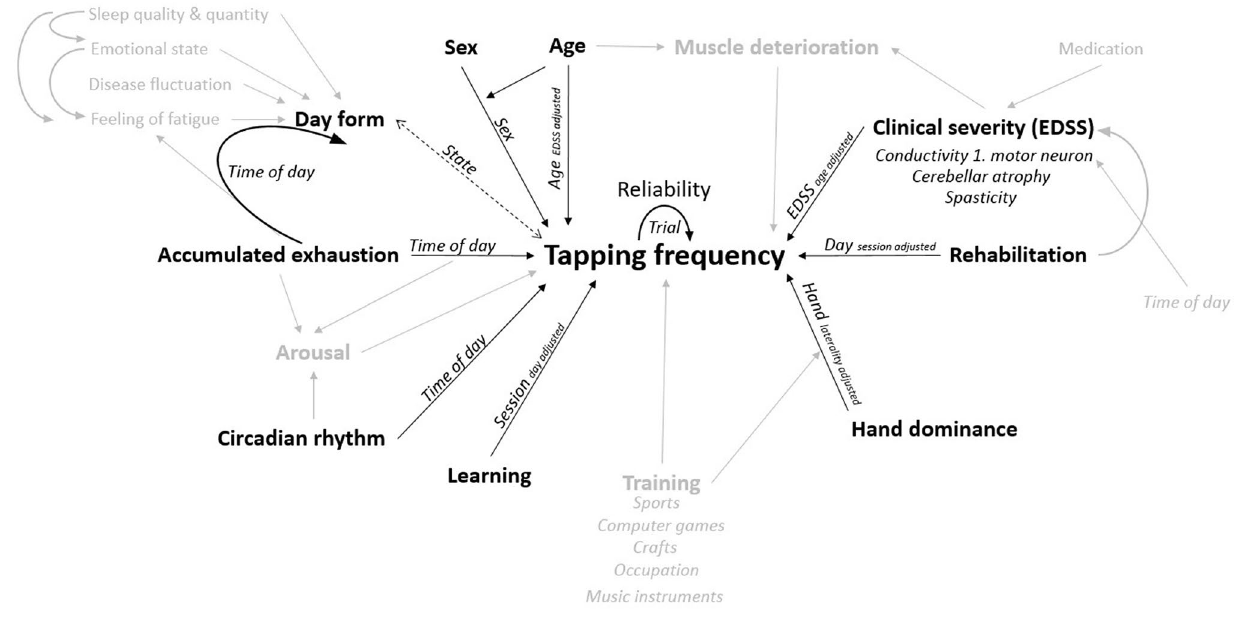
Figure 1. Effect model of factors influencing free finger tapping performance based on current literature. Factors that are in grey were not examined in this study.